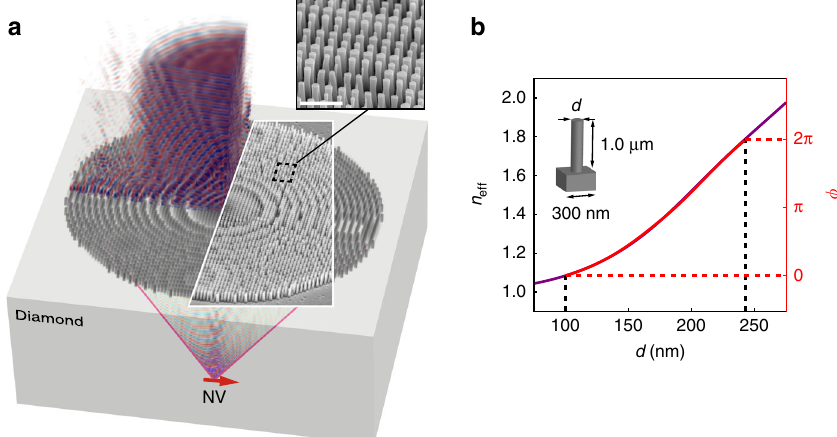
Fig. 1 Diamond immersion metalens. a Subwavelength pillars extending from the surface of a single-crystal diamond substrate are designed to create a high-numerical-aperture immersion lens for coupling nitrogen-vacancy (NV)-center photoluminescence to a collimated beam in air. Inset: Scanning electron microscope (SEM) image of fabricated metalens with closeup of etched diamond pillars. The scale bar corresponds to 1 μ m. b Bloch-mode effective index, n eff , and corresponding optical pathlength difference, ϕ , as a function of pillar diameter, d , at λ = 700 nm. This map is used to create the lens pattern shown in